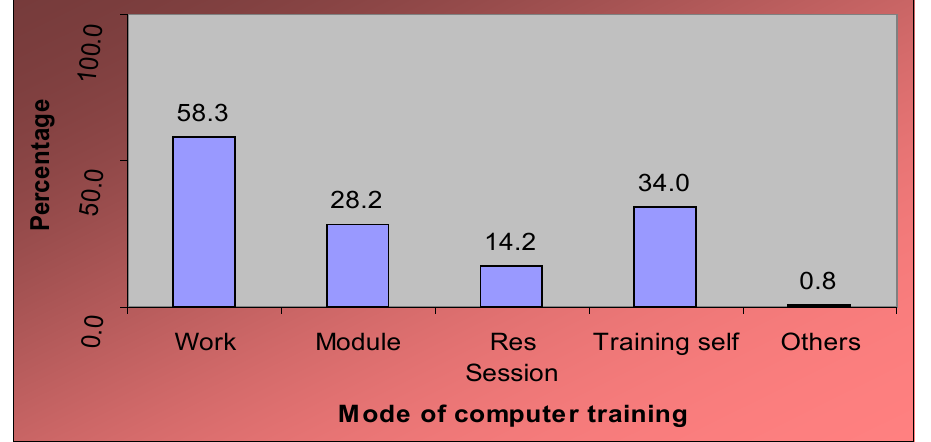
Figure 5 . How computer training was